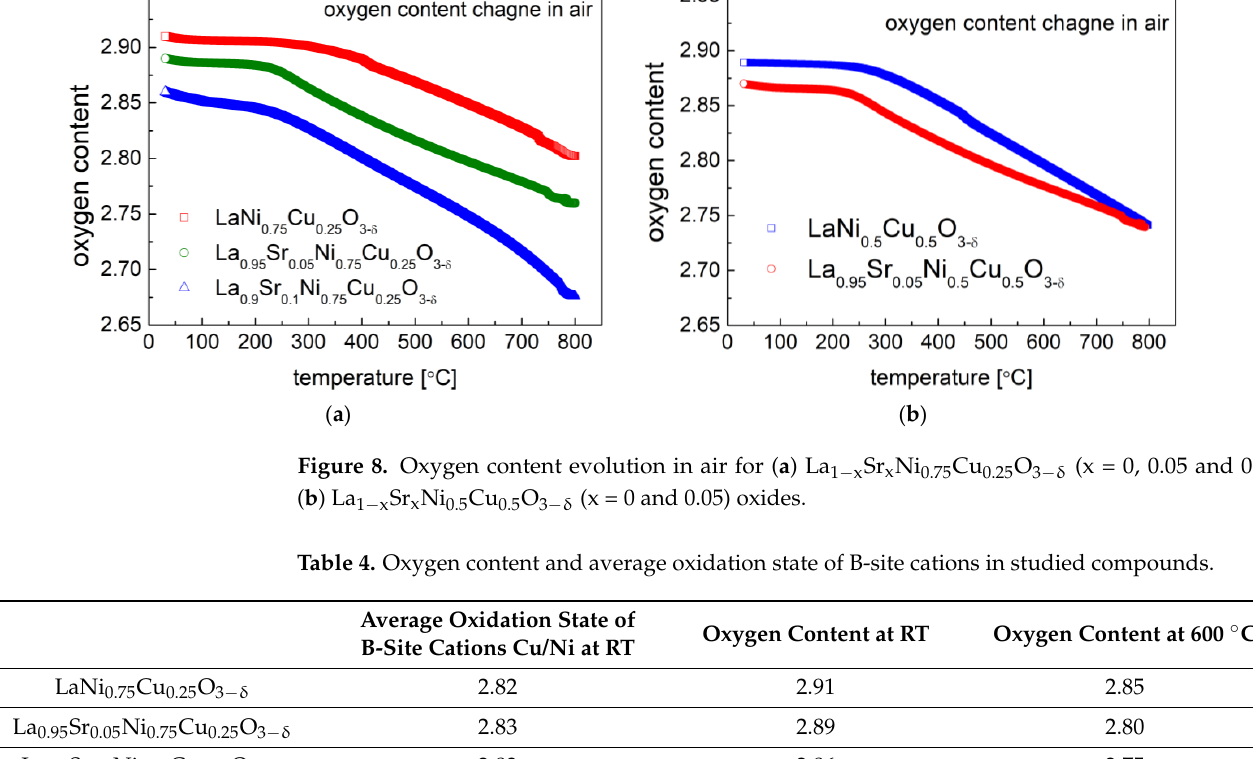
terestingly, the La 0.9 Sr 0.1 Ni 0.75 Cu 0.25 O 3 −δ compound exhibited the highest oxygen non-stoi- chiometry at RT (δ = 0.14) and 600 °C (δ = 0.25) among all the studied materials.